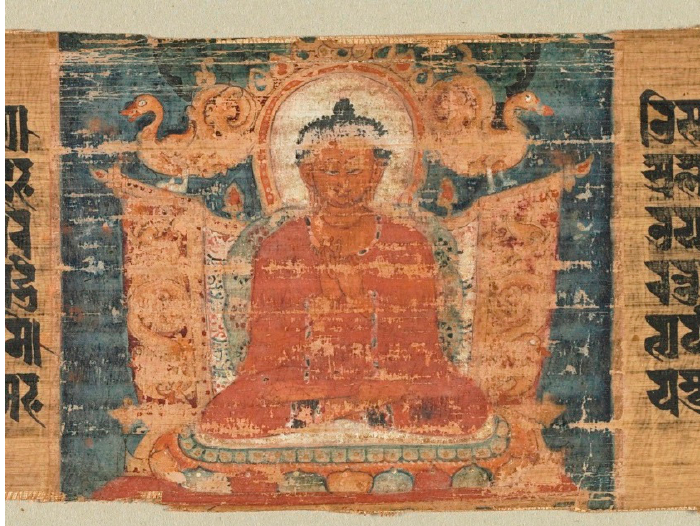
Figure 10. Preaching Amit ā bha, detail of fol. 186v. Perfection of Wisdom in Eight Thousand Lines: A ṣṭ as ā hasrik ā Prajñ ā p ā ramit ā -s ū tra , 1119. Nepal. Gum tempera and ink on palm leaf. 5.5 × 6.25 cm. Cleveland Museum of Art, purchase from the J. H. Wade Fund, 1938.301.4.